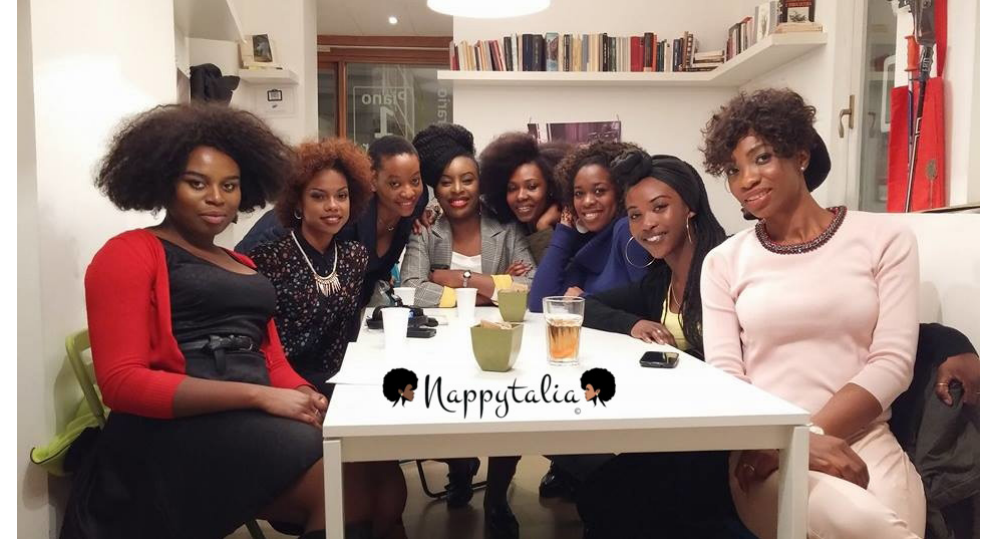
Figure 4. Nappy Hour in Milan, January 2015, from the Nappytalia Facebook